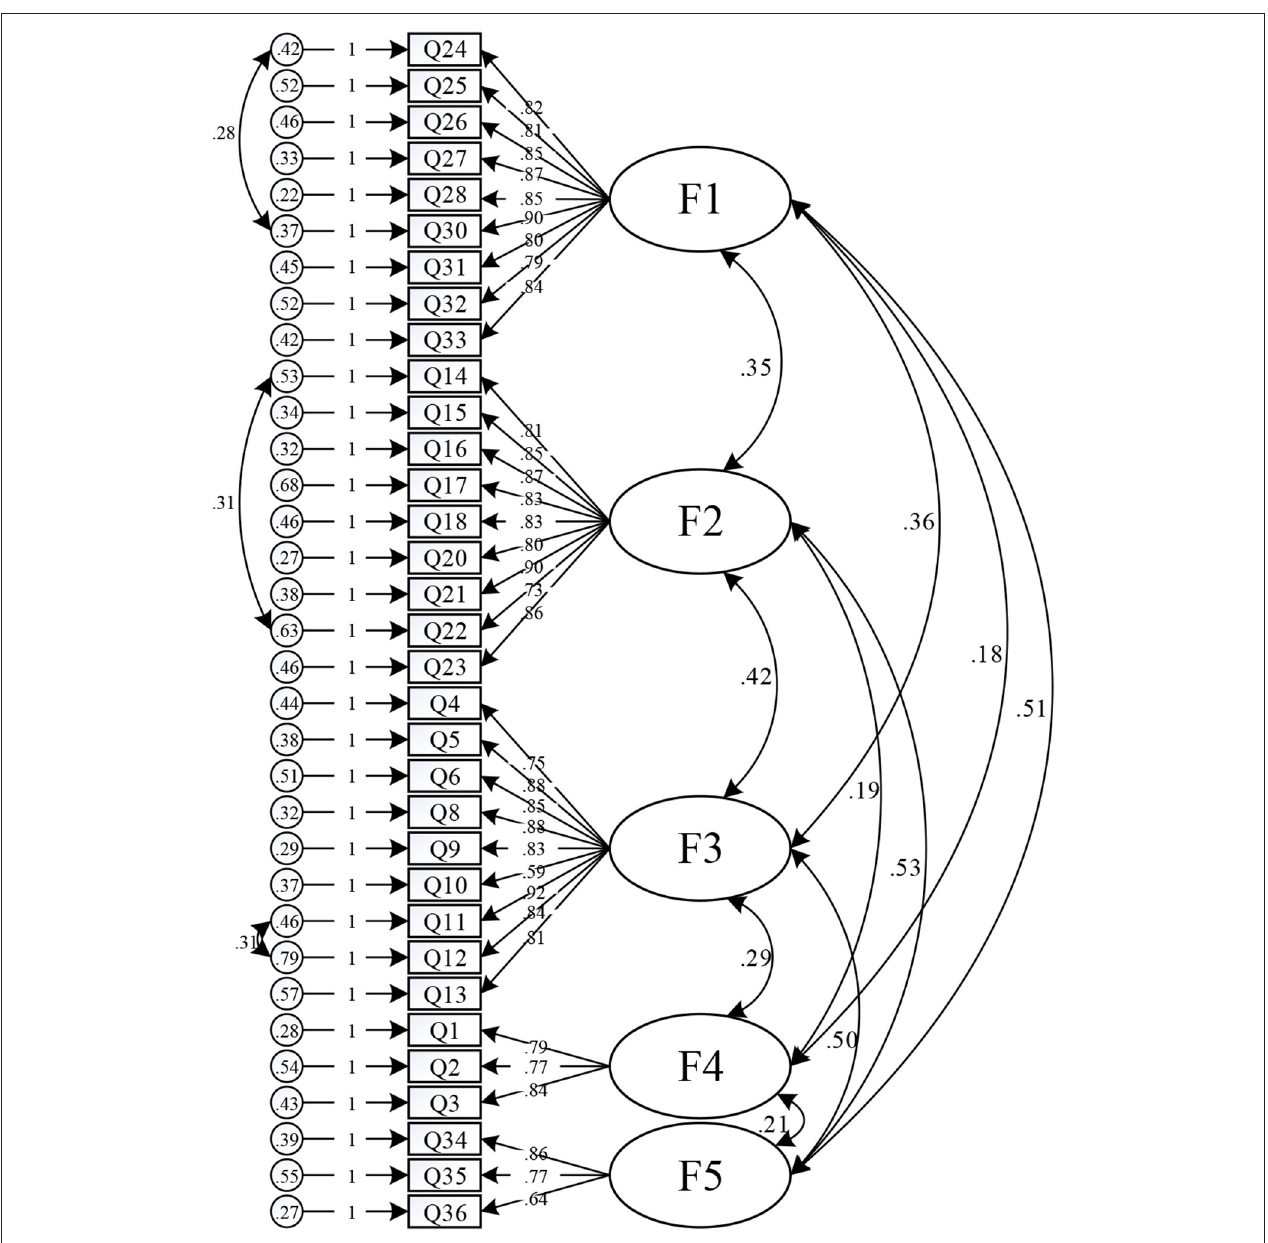
FIGURE 2 | Estimations of the standardized path coefficient of the final confirmatory factor